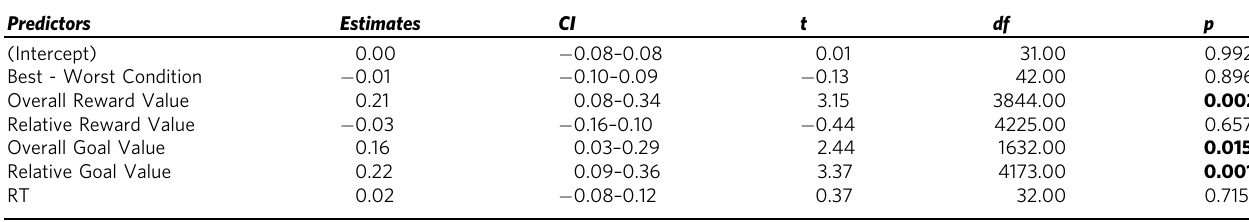
Table 4 Fixed effects summary GLM-3: Reward and goal values Predictors